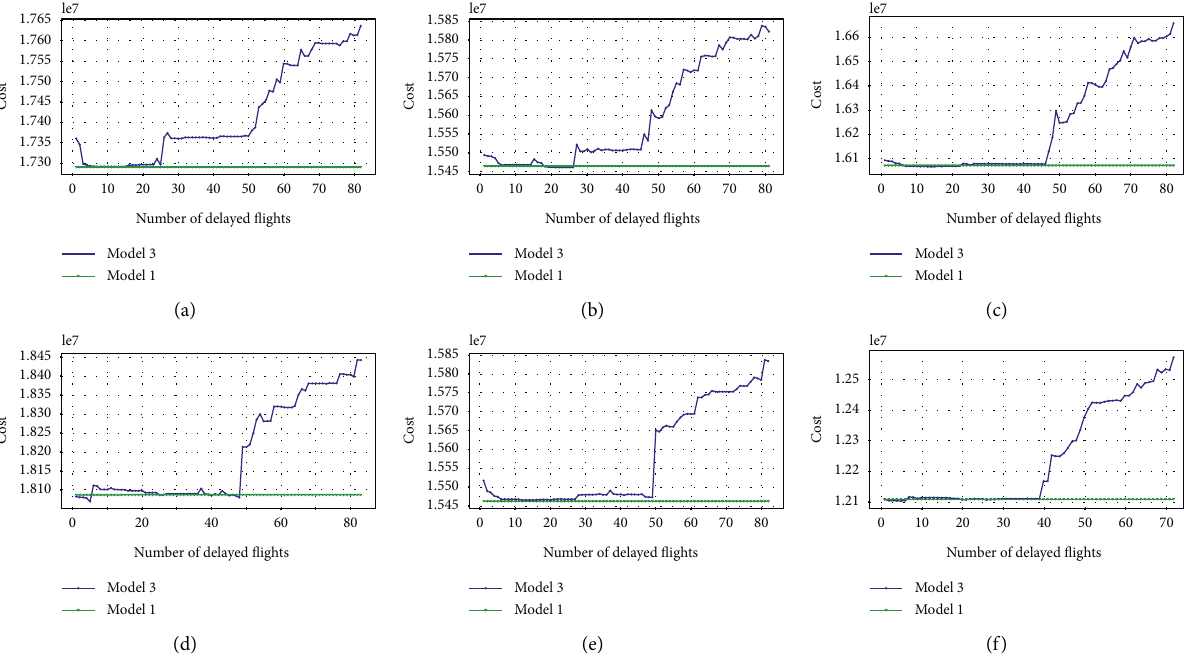
Figure 5: Nondelay costs under diferent models. (a) Monday. (b) Tuesday. (c) Tursday. (d) Friday. (e) Saturday. (f)